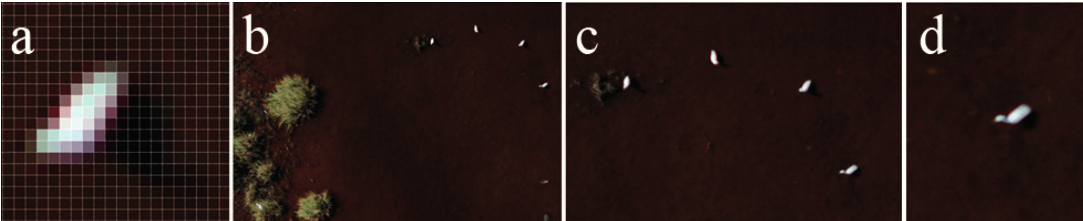
Figure 7. Ortho image map section showing ( a ) a great white egret at the 7 cm spatial resolution (enlarged); ( b ) great white egrets at the 5 cm spatial resolution; ( c ) great white egrets at the 2.5 cm spatial resolution; and ( d ) a great white egret at the 1 cm spatial resolution.